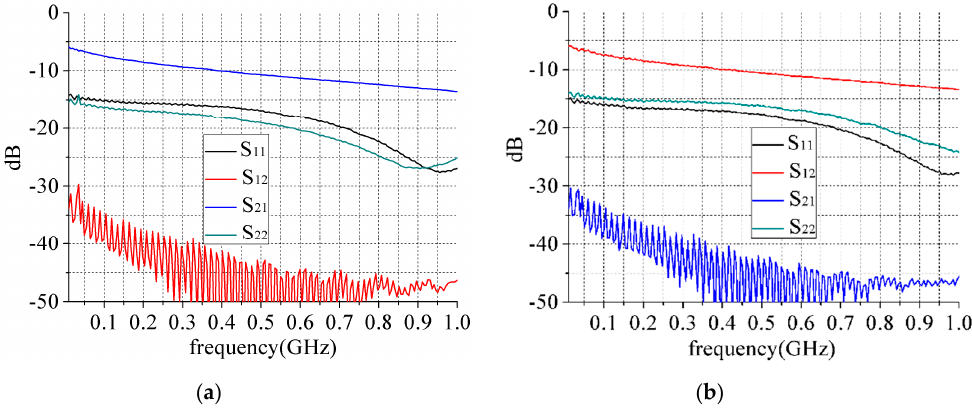
Figure 10. The measurement results with ( a ) clock signals unchanged and with ( b ) changed clock signals.